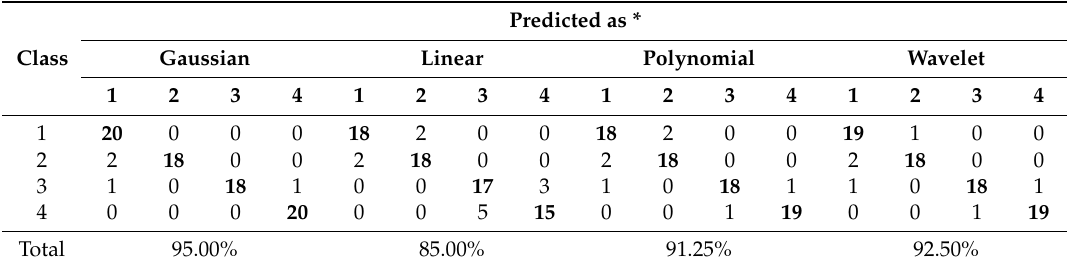
Table 6. Classification results of four kernel functions used in the QPSO-KELM model.